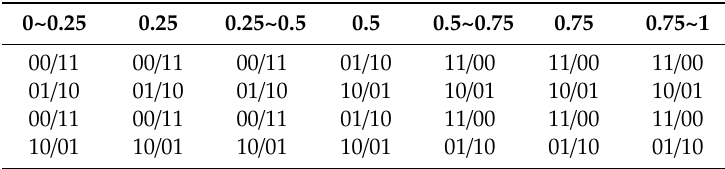
Figure 4. The key waveform of two arms series. ( a ) Mode 0.5 < D < 0.75, ( b ) Mode 0.25 < D < 0.5. Table 2. Two arms complementary series